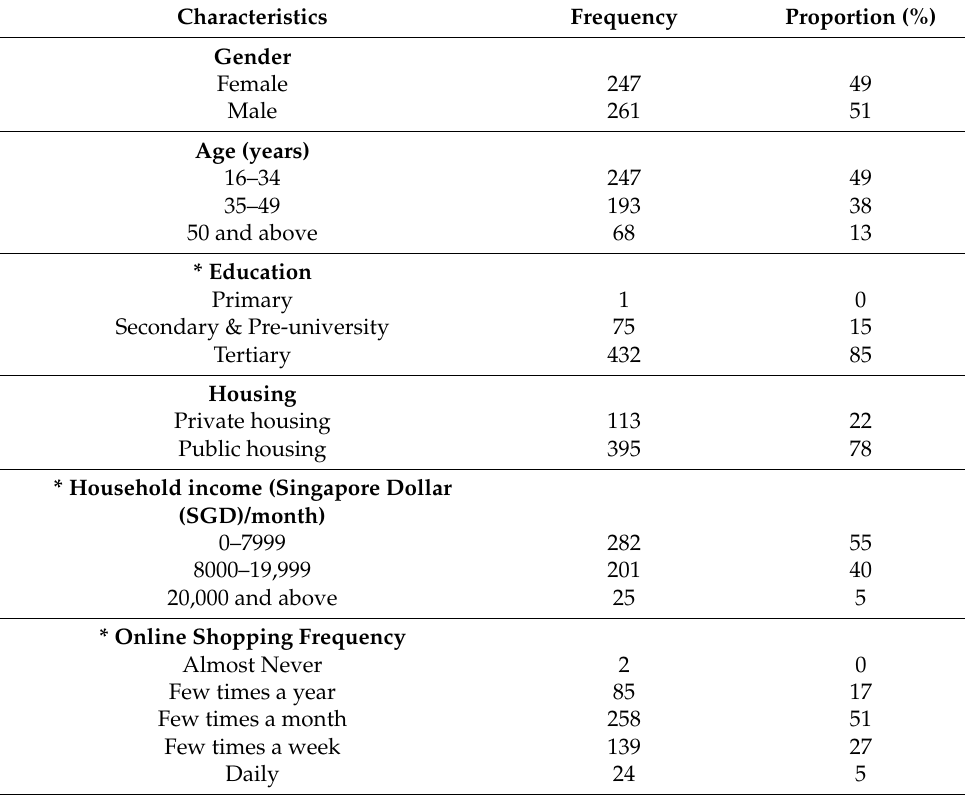
Table 3. Respondent’s